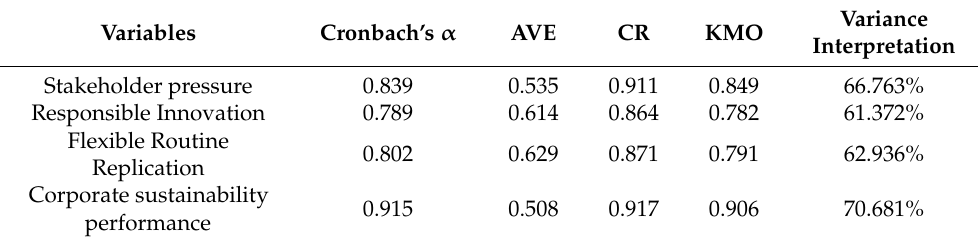
Table 1. Reliability and validity test